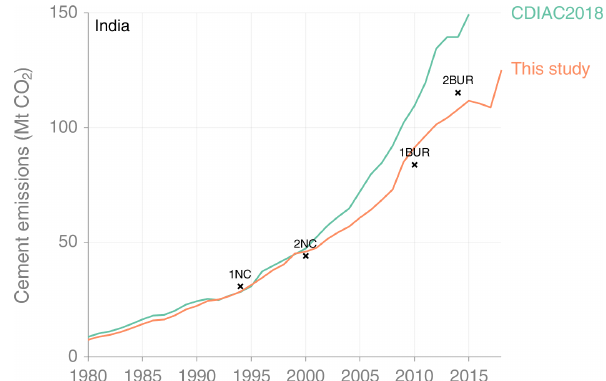
Figure C7. Revised cement emissions for India. 1NC: First Na- tional Communication; 2NC: Second National Communication; 1BUR: First Biennial Update Report; 2BUR: Second Biennial Up- date Report.